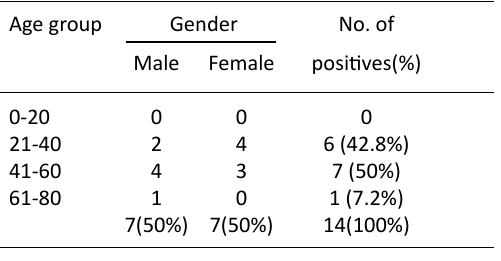
Table 3. Seasonal and area distribution of positive scrub typhus samples S. Variable